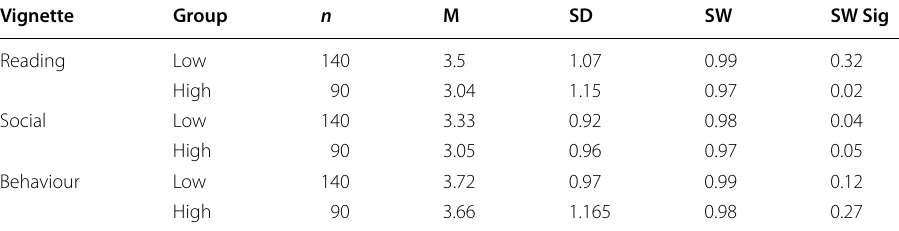
Table 3 Descriptive statistics for acceptability as a function of vignette and child anxiety (transformed data)